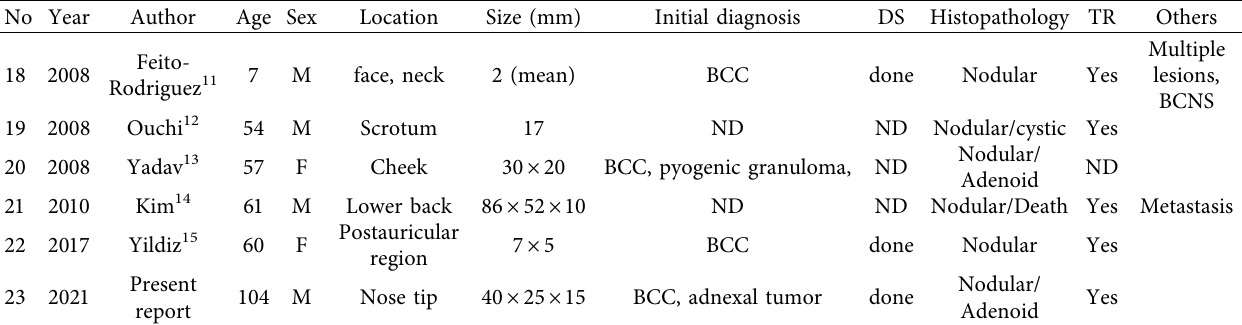
(Figure 1(g)). ki67-positive cells were not clearly different between shallow and deep lesions, and EMA was negative (data not